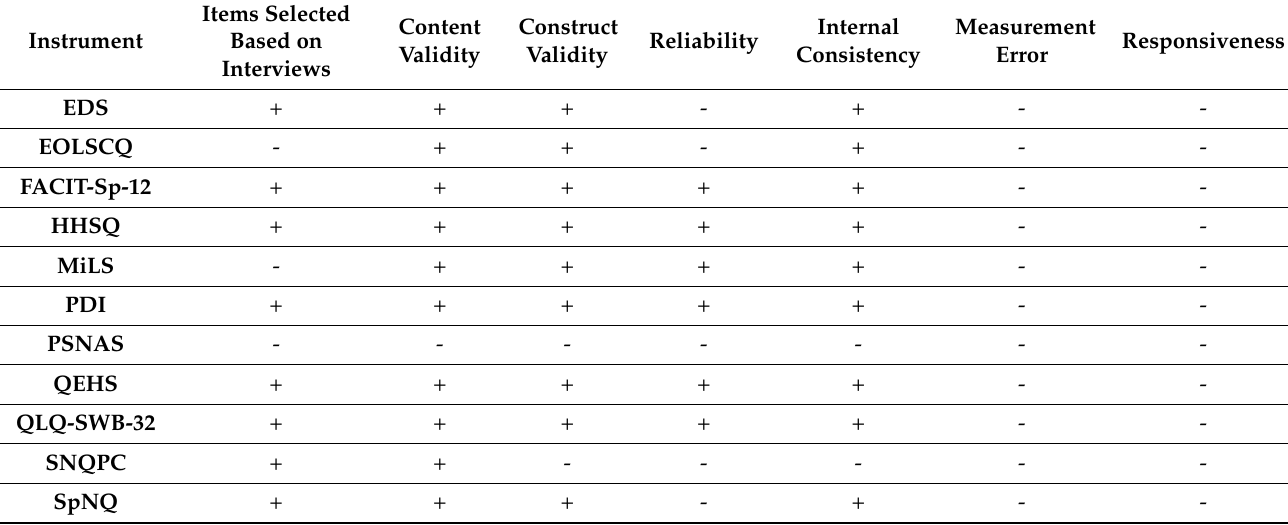
Table 5. Clinimetric properties self-reported in primary